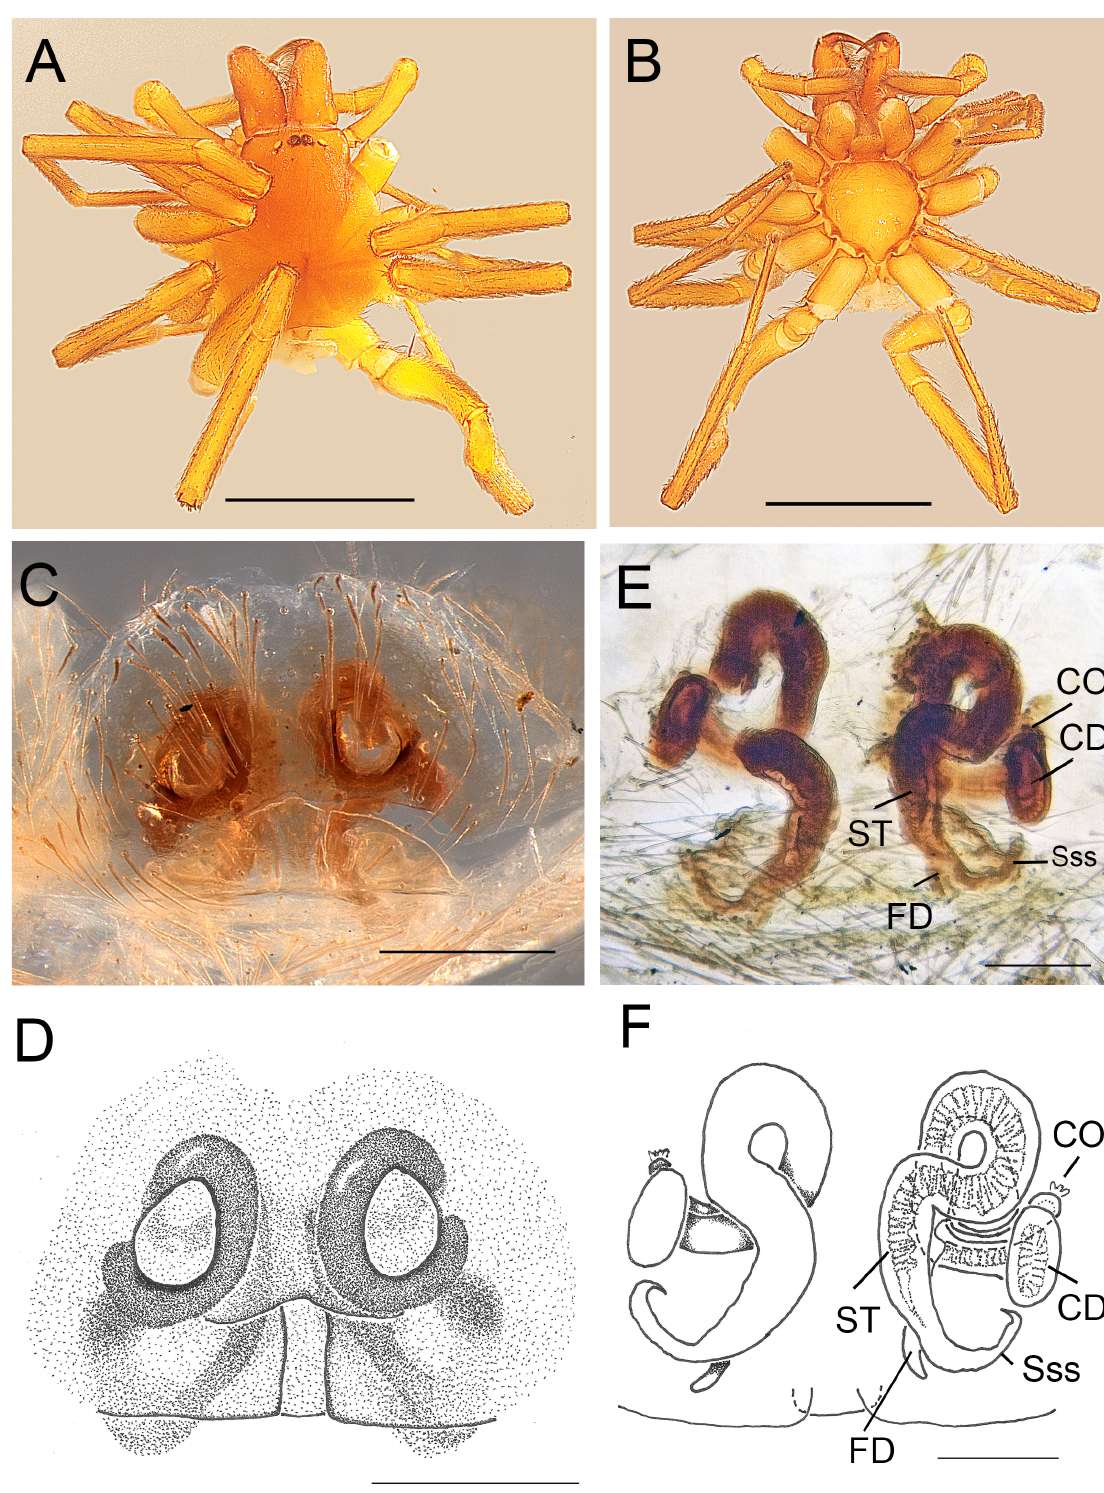
Fig. 18. Andromma deogratias sp. nov., ♀, paratype (BE_RMCA_ARA.Ara 246054). A . Cephalothorax, dorsal view. B . Same, ventral view. C–D . Epigyne, cleared, ventral view. E–F . Same cleared, dorsal view. Abbreviations: CD = copulatory duct; CO = copulatory opening; FD = fertilisation duct; Sss = sickle shaped sclerites; ST = spermatheca. Scale bars: A–B = 2 mm; C–D = 0.2 mm; E–F = 0.1